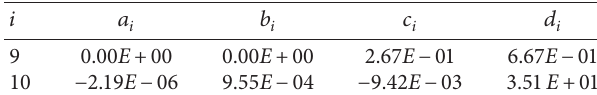
Table 2: Identified parameters of the extracted hysteresis